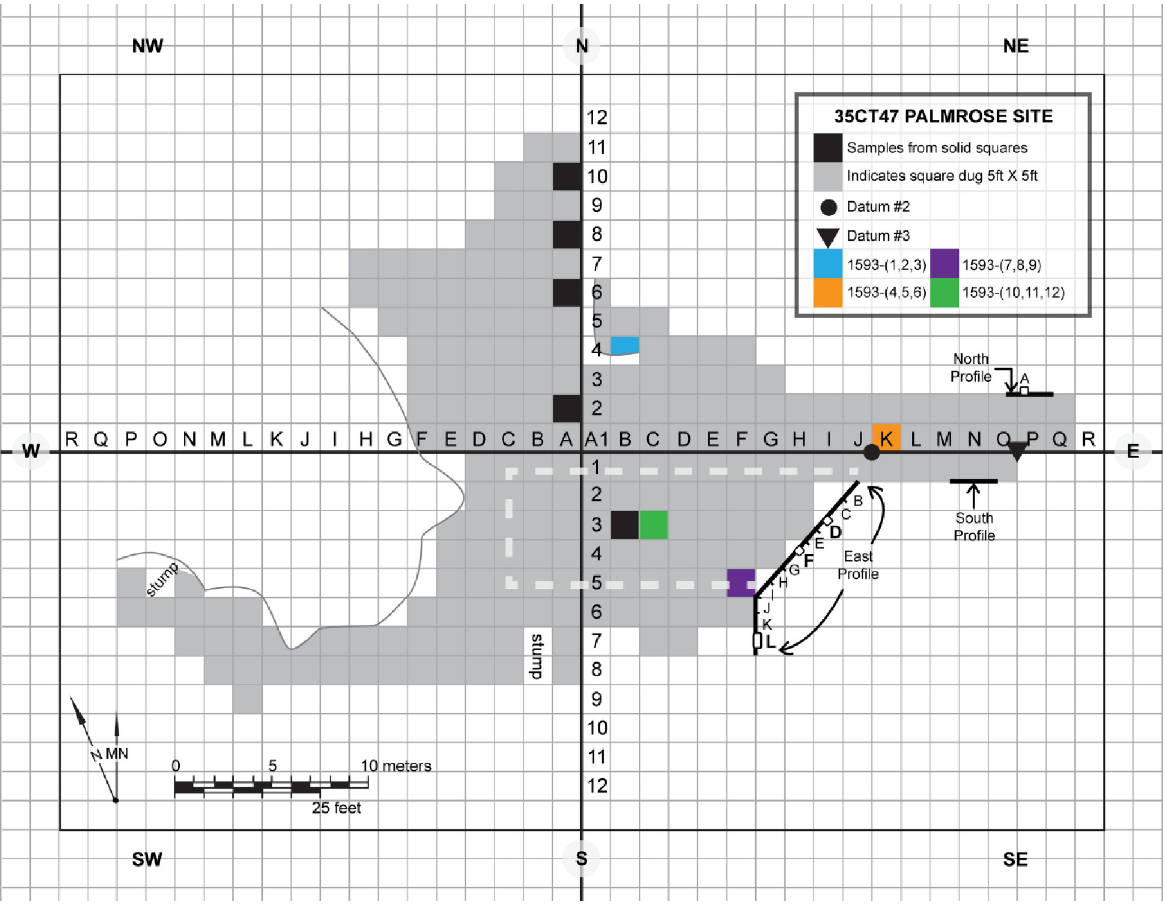
Fig 2. Grid map of the Palmrose site depicting excavation units sampled for radiocarbon dating (colored units) and the MNCH profiles from 1988. Grey units represent the extent of Phebus and Drucker’s excavations. Adapted from Connolly (42) with permission from the Museum of Natural and Cultural History, original copyright